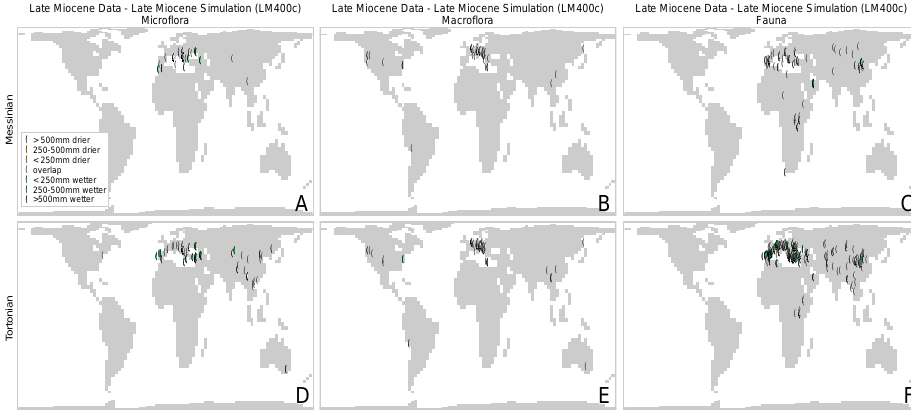
Fig. 13. Results from the model–data comparison for mean annual precipitation, late Miocene